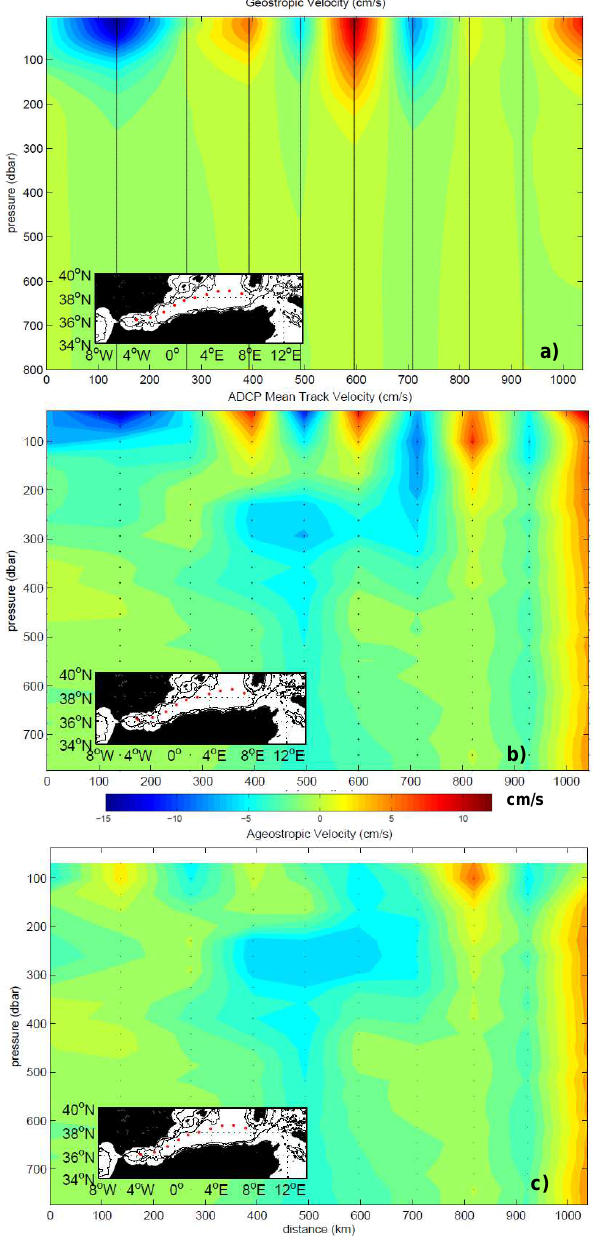
Figure 10. Velocity distribution on a section through the eastern Mediterranean Sea. The inset panels show the location and nodes of the section. Left axis of panels: depth in dbar; lower axis: distance in km. (a) Geostrophic velocity determined between the CTD sta- tions. (b) Mean ADCP velocity across the section between adjoin- ing CTD stations. Mean is the average between two CTD stations. (c) Ageostrophic velocity determined by subtracting the geostrophic velocity from the mean ADCP velocity. Reference layer of no mo- tion for geostrophic velocities is